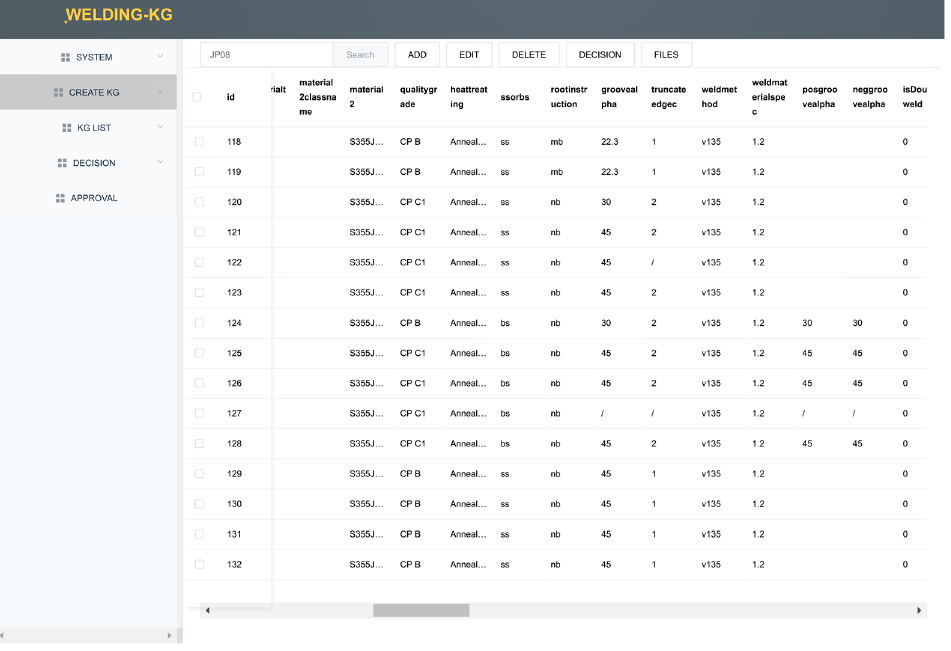
Figure 5. Batch data decision making.